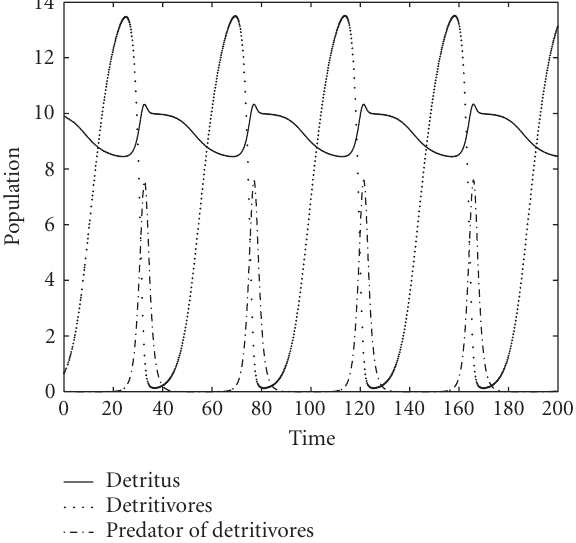
Figure 5.3. Unstable population distribution of the model (5.1) with the parametric values as de- scribed in the